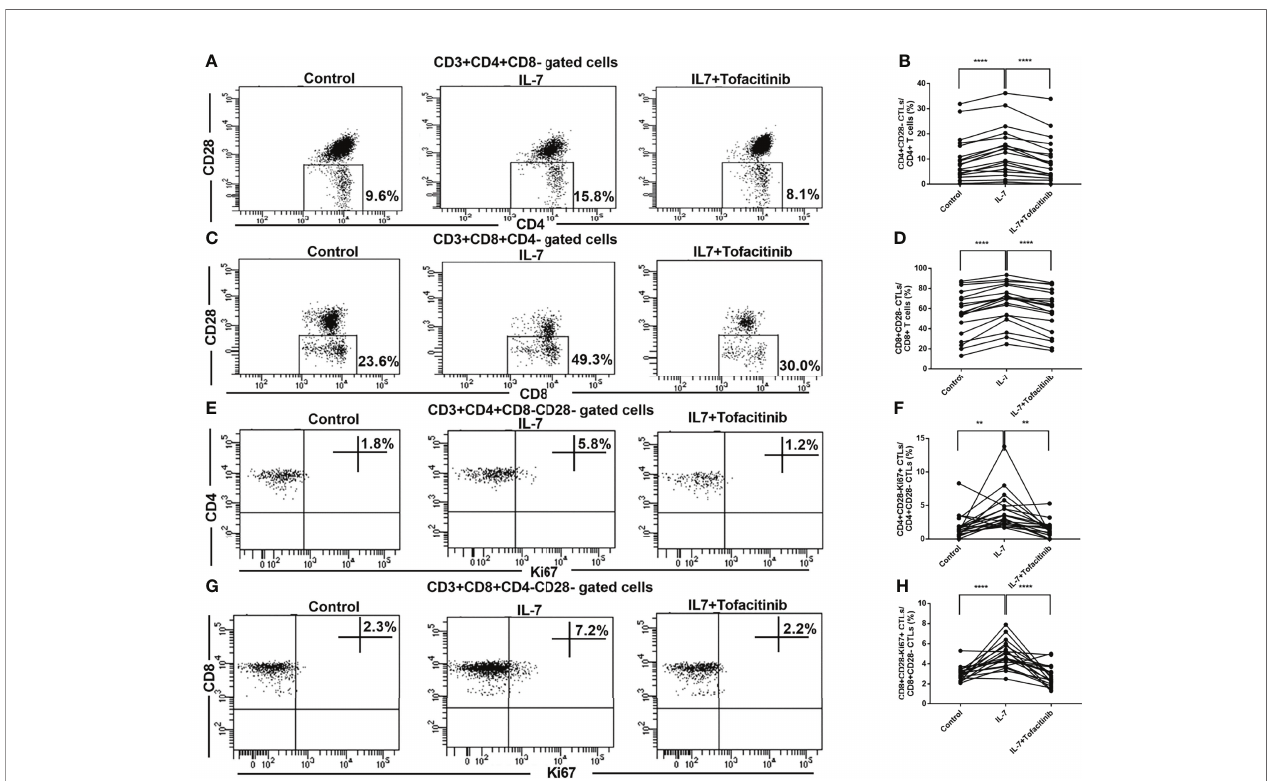
FIGURE 4 | Expression and activation analysis of CD28- CTLs in peripheral blood from IgG4-RD patients with the addition of IL-7 and JAK inhibitor. PBMCs extracted from IgG4-RD patients were cultured with 50 ng/mL IL-7 in the presence or absence of 150 nM JAK inhibitor tofacitinib for 4 days. (A, C) Representative dot plots of fl ow cytometry analysis. CD4+CD28- and CD8+CD28- CTL percentages in CD4 and CD8 T cells were indicated. (B, D) The percentages of CD4+CD28- CTLs and CD8+CD28- CTLs in IgG4-RD patients (n = 19) were compared between IL-7-treated and untreated samples, and between IL-7-treated and IL-7 plus tofacitinib samples as well. The paired two-tailed Student ’ s t-test was used to compare two groups. **** P < 0.0001. (E, G) Representative dot plots of fl ow cytometry analysis. Ki67+ cell percentages in CD4 +CD28- and CD8+CD28- CTLs were shown. Ki67 was gated according to fl uorescence minus one (FMO) control of Ki67, and Ki67 staining after PBMC stimulation with PMA for 6 hours was used as a positive control for gating. (F, H) Ki67+ cell percentages in CD4+CD28- CTLs and CD8+CD28- CTLs in IgG4-RD patients (n = 19) were compared between IL-7-treated and untreated samples, and between IL-7-treated and IL-7 plus tofacitinib samples as well. The paired two-tailed Student ’ s t-test was used to compare two groups. ** P < 0.01; **** P <